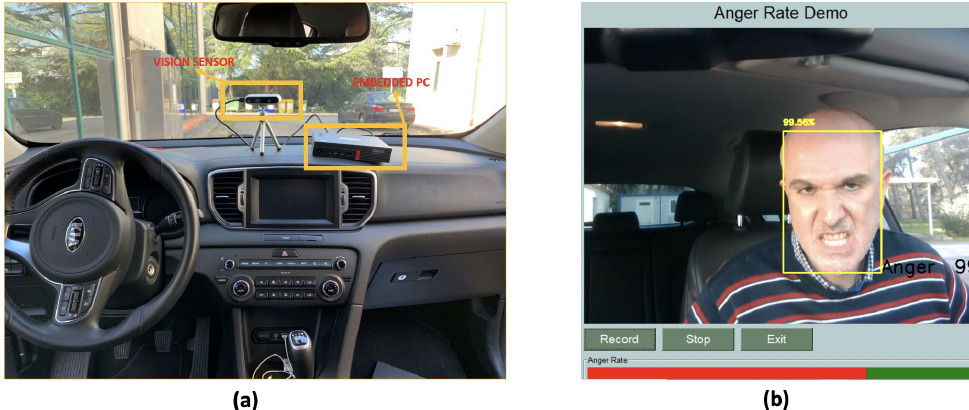
Figure 8. ( a ) experimental setup ( b ) a screenshot of the software application developed for road rage